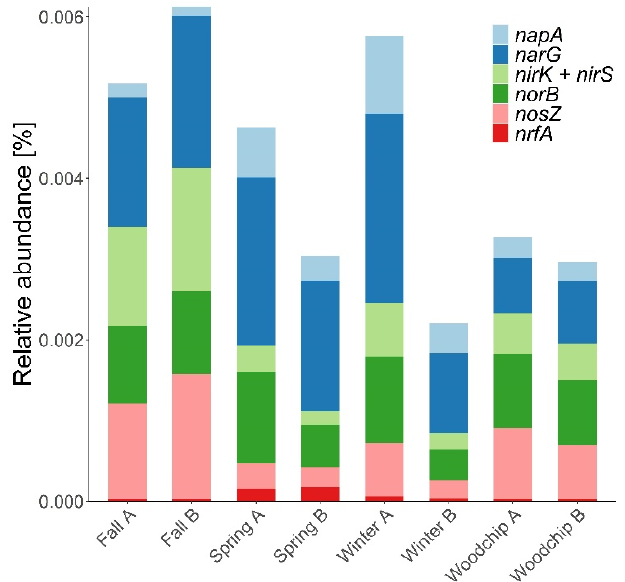
Figure 4. Relative abundance of genes related to denitrification and dissimilatory nitrate reduction to ammonia ( nrfA ) in enrichments (spring, fall and winter) and native woodchip samples (fall). Denitrification genes included nitrate reductases ( nar , nap ), nitrite reductases ( nir ), nitric oxide reductases ( nor ) and nitrous oxide reductases ( nosZ ). The results are presented as the number of hits attributed to each gene in percent of the total number of hits obtained from the samples with the KO database [35]. The A and B notations refer to biological replicates.